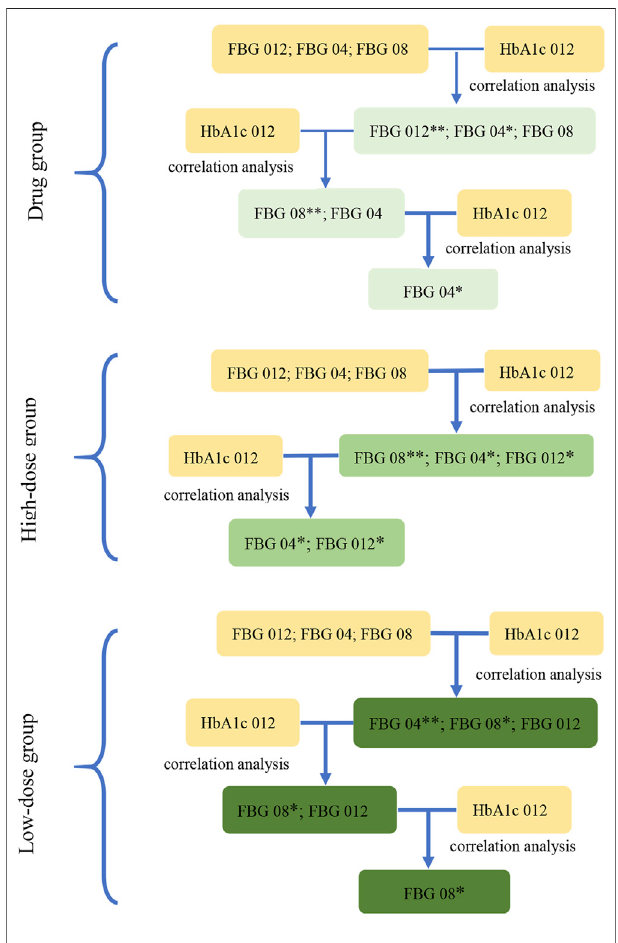
FIGURE 3| The screening diagram of the keyindications instudy 2. The correlation between the indications (FBG 04, FBG 08, FBG 012), which were the changes from baseline in FBG (obtained from the results in study 1) at week 4, week 8, and week 12, and HbA1c 012 were analyzed respectively to screen the related indications and their associated P-values. Then, removed the indications with the maximum P-value (**) at each step, and conducted the correlation analysis between the rest of indications and HbA1c 012 to screen the related indications at p < 0.1 (*) in three groups.